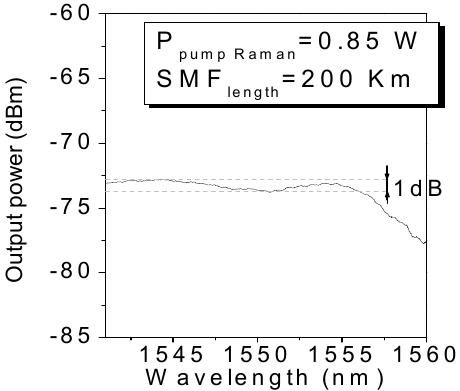
Figure 4. Amplified spontaneous emission at 200